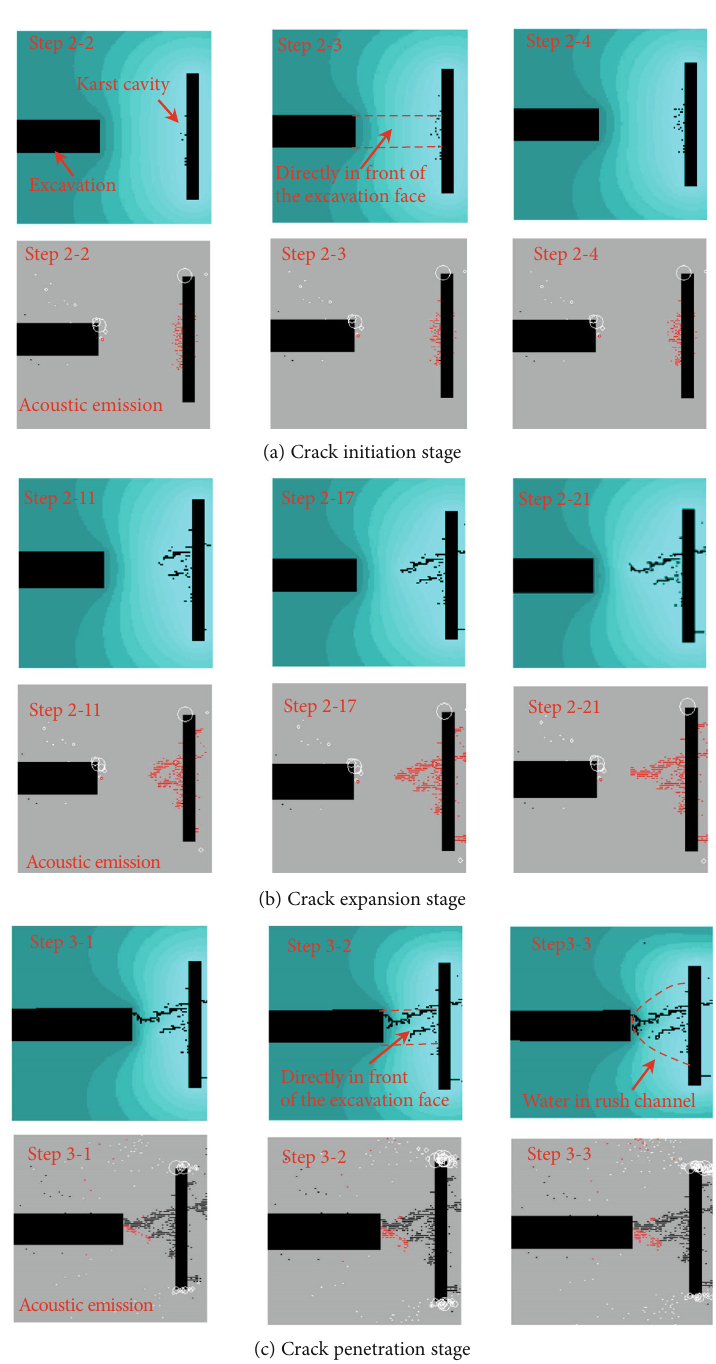
Figure 9: Crack fi eld and acoustic emission